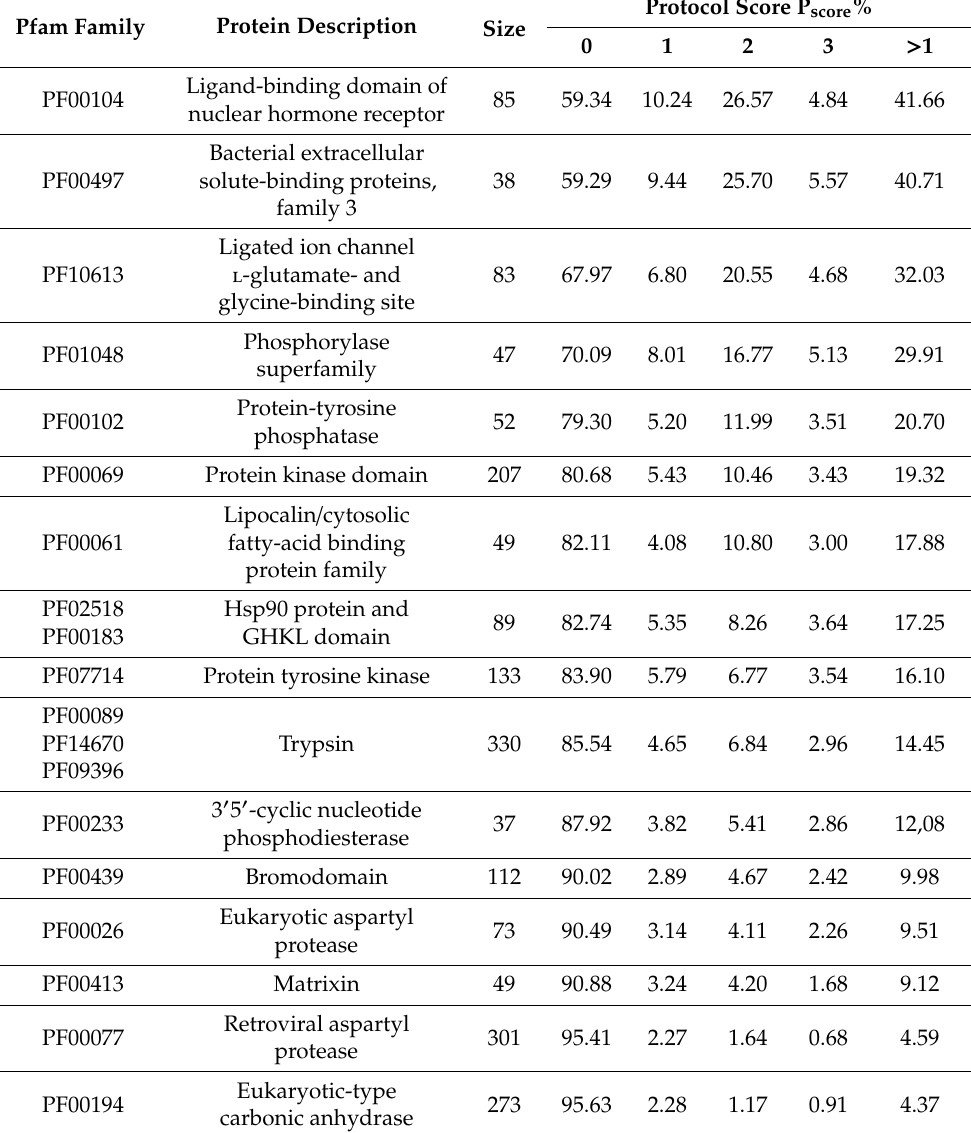
Table 2. Summary of benchmark results by Pfam families. Protocol scores are reported as percentage with respect to the total docking runs (P score